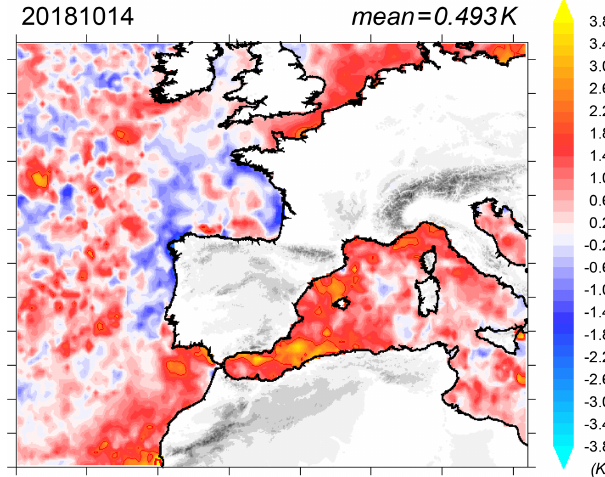
Figure 3. Daily SST anomaly (K) for 14 October 2018 from the OSTIA